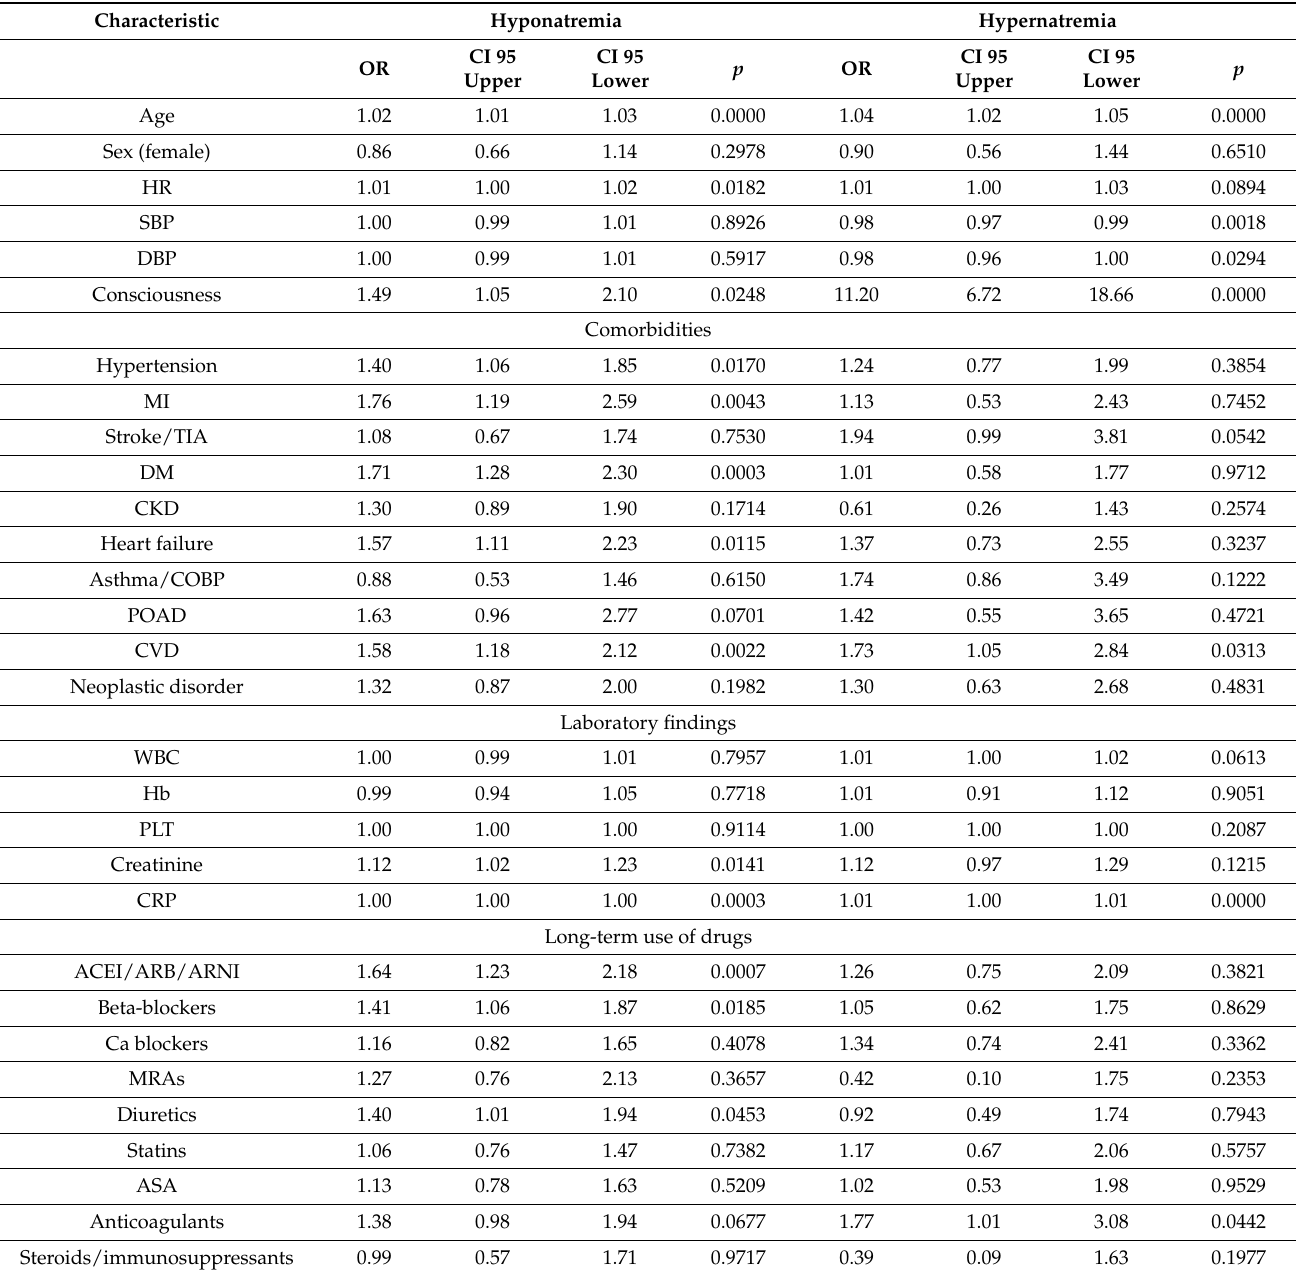
Table 4. Results of univariate analysis, predictors of hyponatremia and